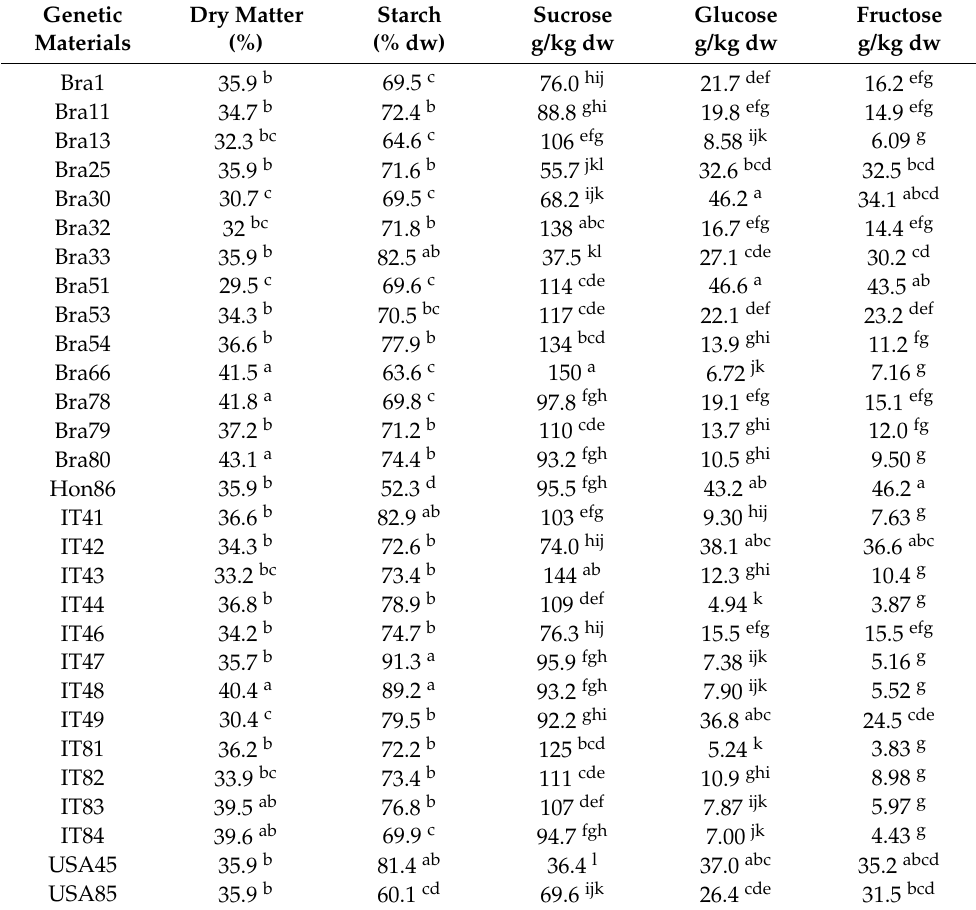
Table 2. Main qualitative composition of the tested sweet potato